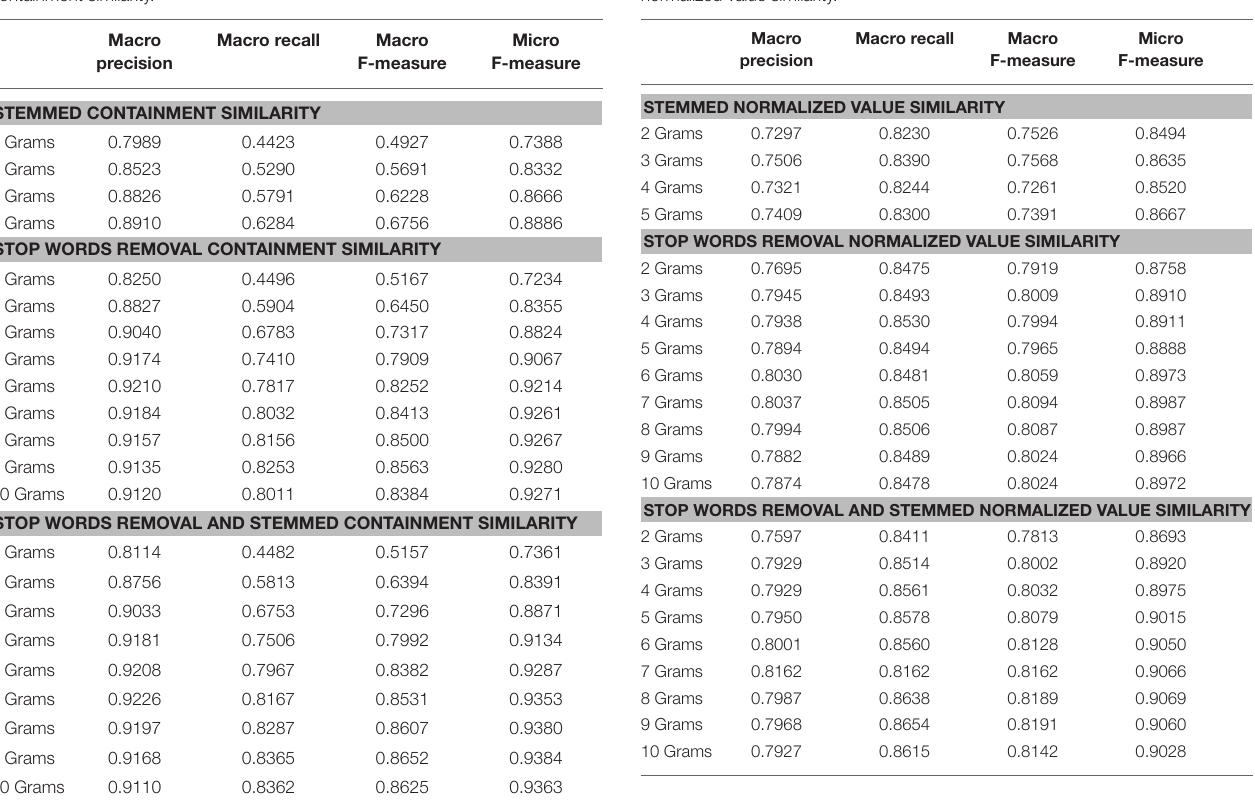
TABLE 5 | Evaluating preprocessing techniques with Reuters-21578 and normalized value